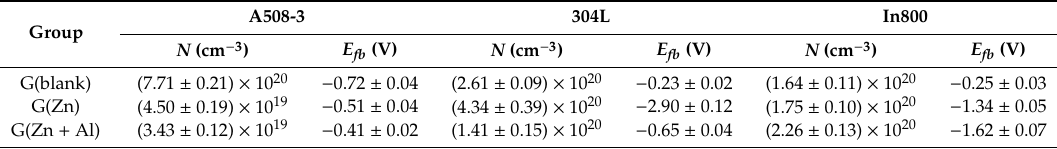
Figure 4. The Mott–Schottky curves of the passive films formed on ( a ) A508-3, ( b ) 304L and ( c ) In800 with di ff erent treatment methods. Table 5. The n-type semiconductor parameters of the passive films formed on A508-3, 304L and In800 with di ff erent treatment